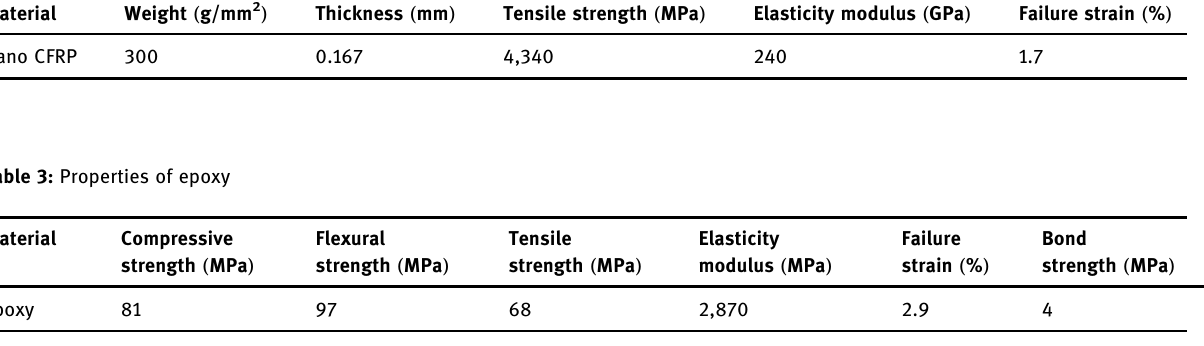
Table 2: Properties of nano CFRP Material